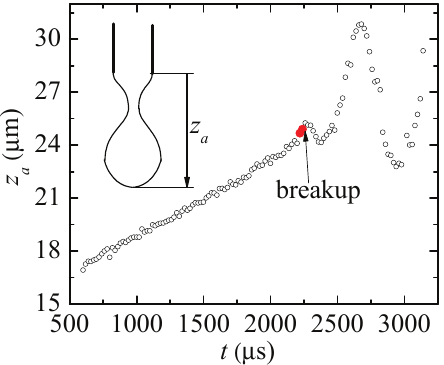
Figure 2. Vertical position z a of the apex during the pendant drop breakup for PEO ( M w = 2 × 10 6 g/mol, c = 0.0003%) . The red big circles indicate the time interval used to determine the relaxation